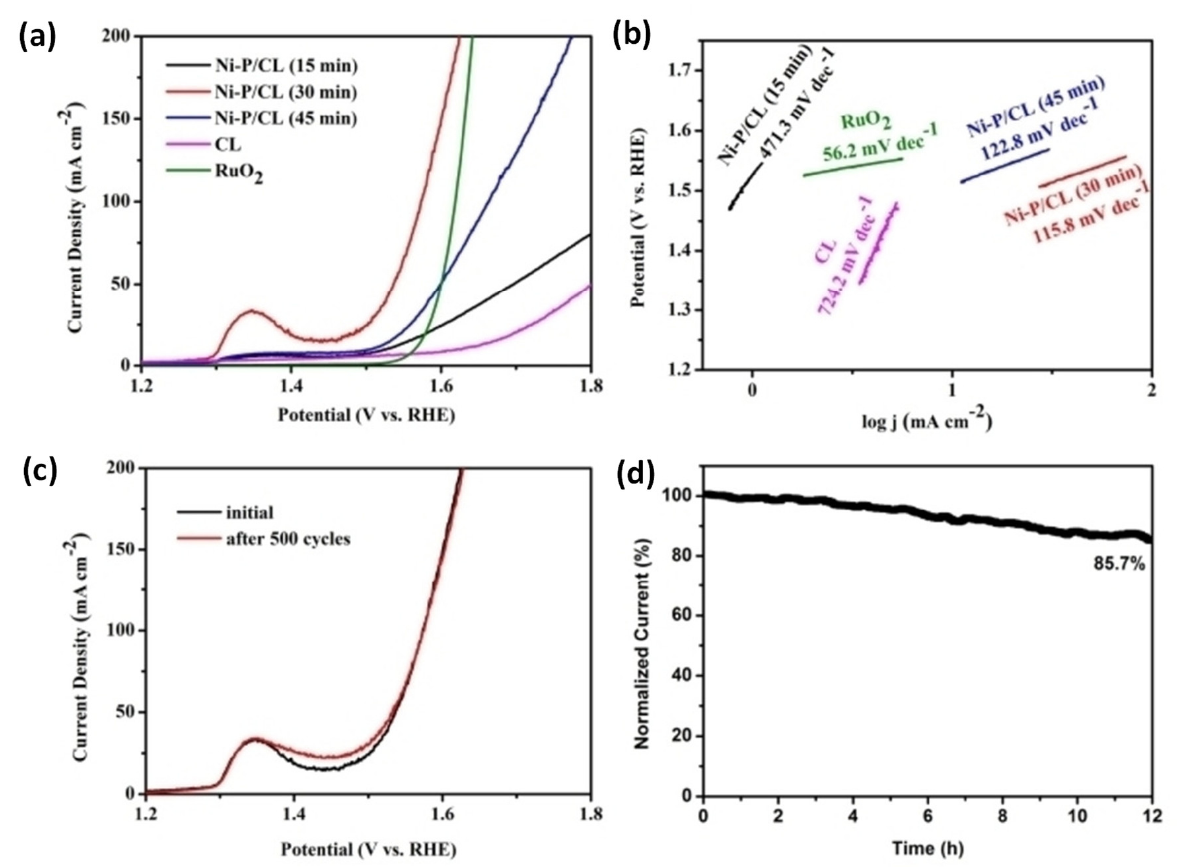
Figure 12. ( a ) LSV curves and ( b ) Tafel plots of Ni-P anchored in holly leaves-derived carbon (Ni-P/CL) with different deposition times (15, 30, and 45 min), the original carbon substrate (CL) and commercial RuO 2 ; ( c ) LSV curves of Ni-P/CL (30 min) during the initial and 500th cycle; and ( d ) chronoamperogram obtained at E = 1.6 V vs. RHE. Reproduced from [194] with the permission of Wiley.